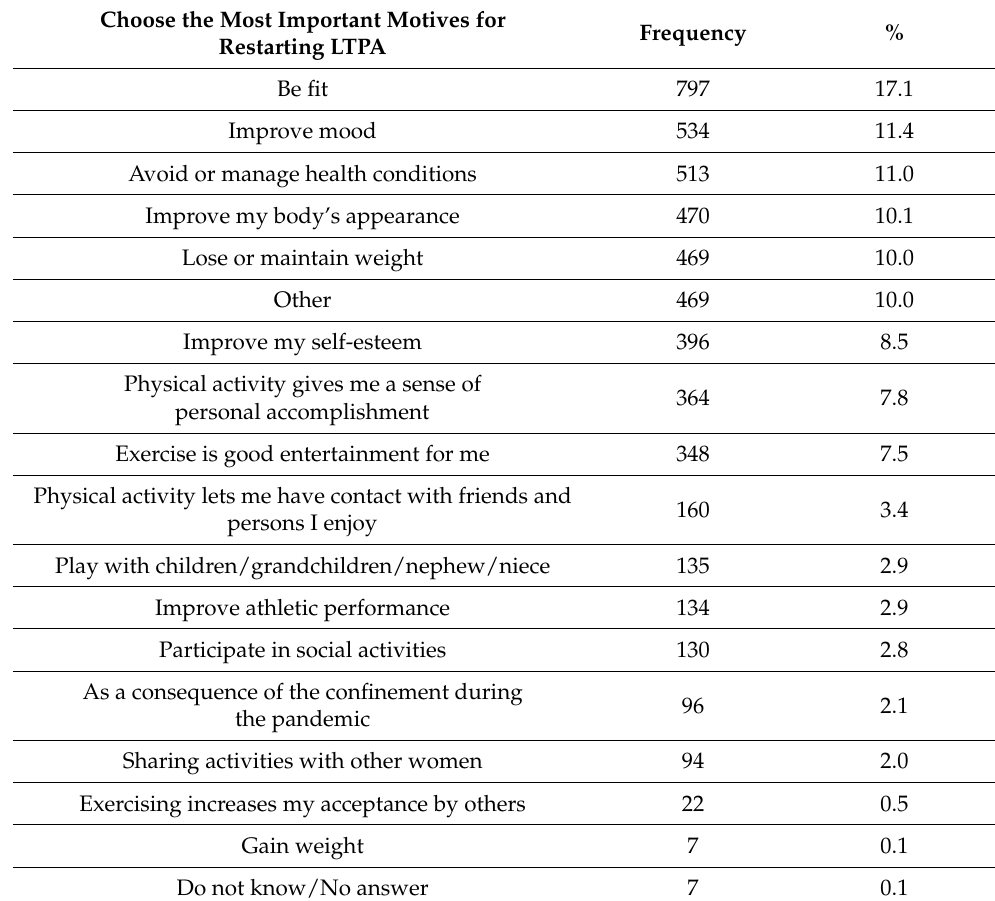
Table 5. Inactive group participant responses regarding the motives for why they might restart LTPA (total responses ( n ) =